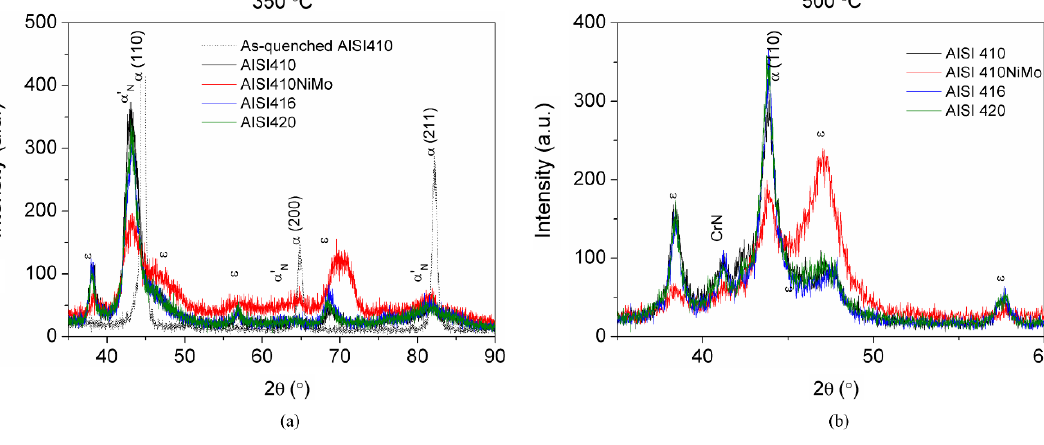
Figure 6. X-ray diffraction patterns of all studied steels nitrided at: (a) 350°C; and (b) 500°C. Treatments carried out for 4 h, using a gas mixture composition of 70%